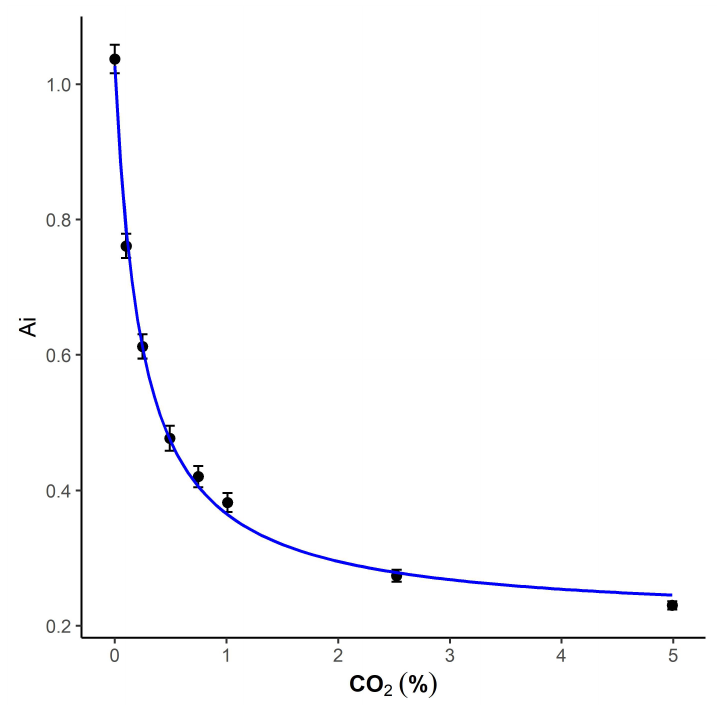
Figure A2. Nonlinear calibration curve for MicroResp. The x axis shows the percentage air fraction of CO 2 and the y axis shows the normalized absorbance at 572 nm.